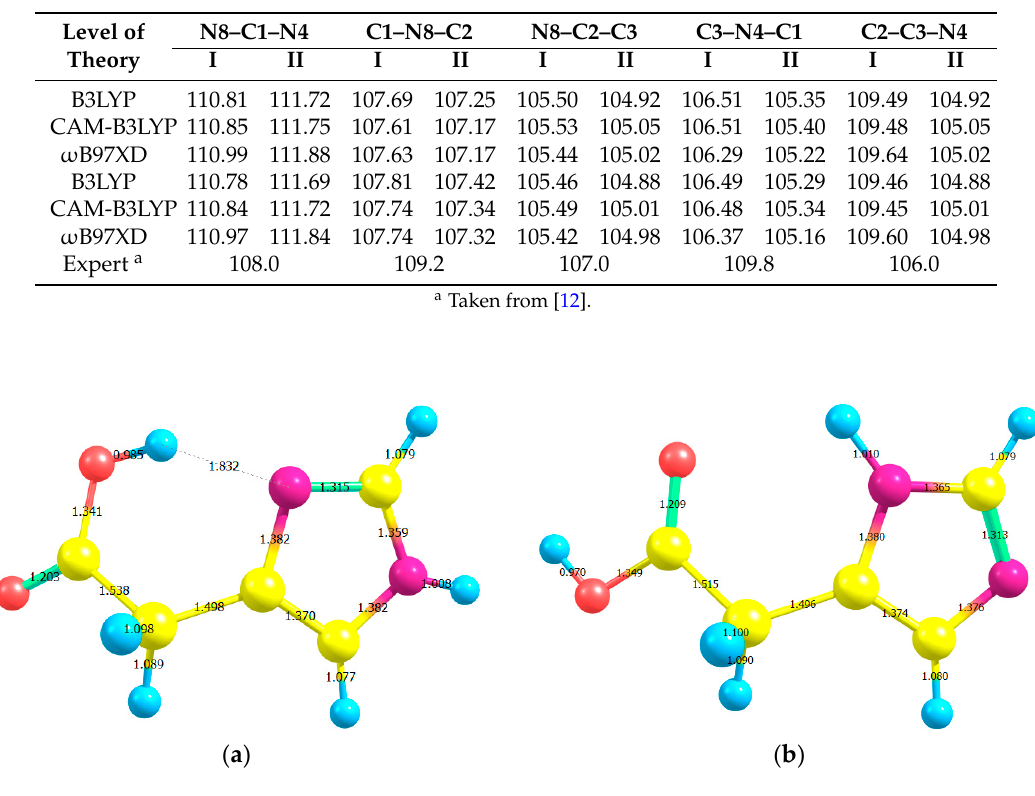
Figure 2. The optimized bond lengths of ( a ) H-bonded imidazole-4-acetic acid (I) and ( b ) imidazole-5-acetic acid (II) using B3LYP/6-311++G** level of theory.